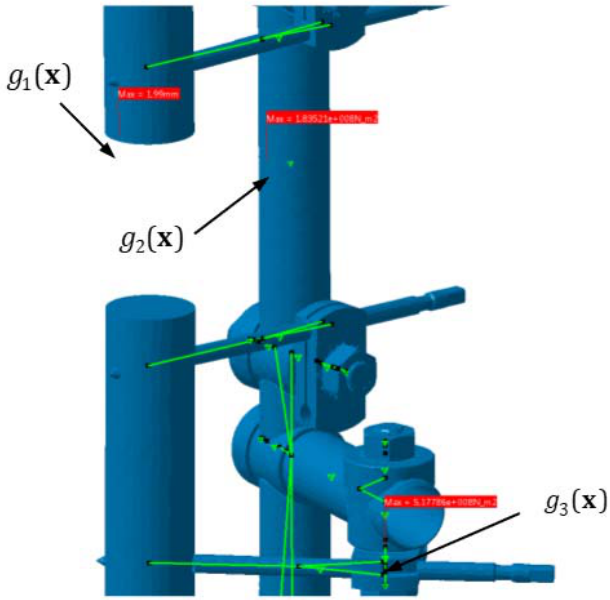
Figure 12. Optimization constrains on FEM model.